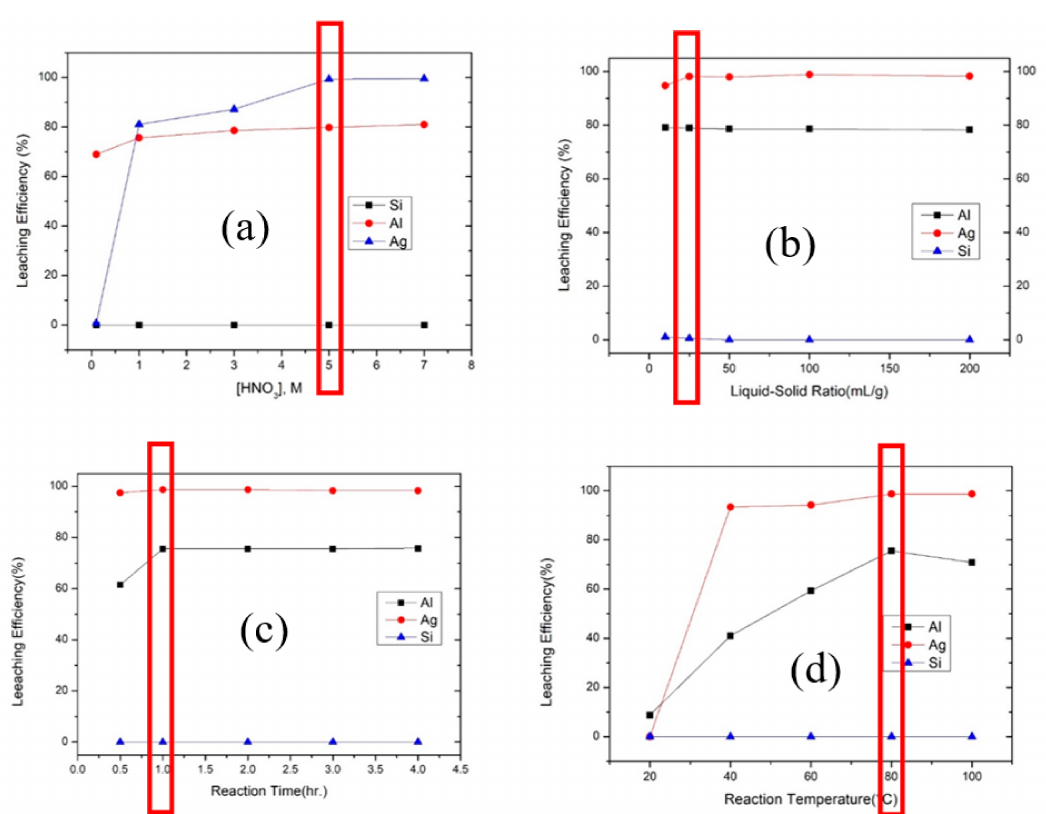
Figure 3. The optimized parameters of first step leaching (HNO 3 ): ( a ) Concentration of nitric acid, ( b ) liquid–solid ratio, ( c ) reaction time, and ( d ) reaction